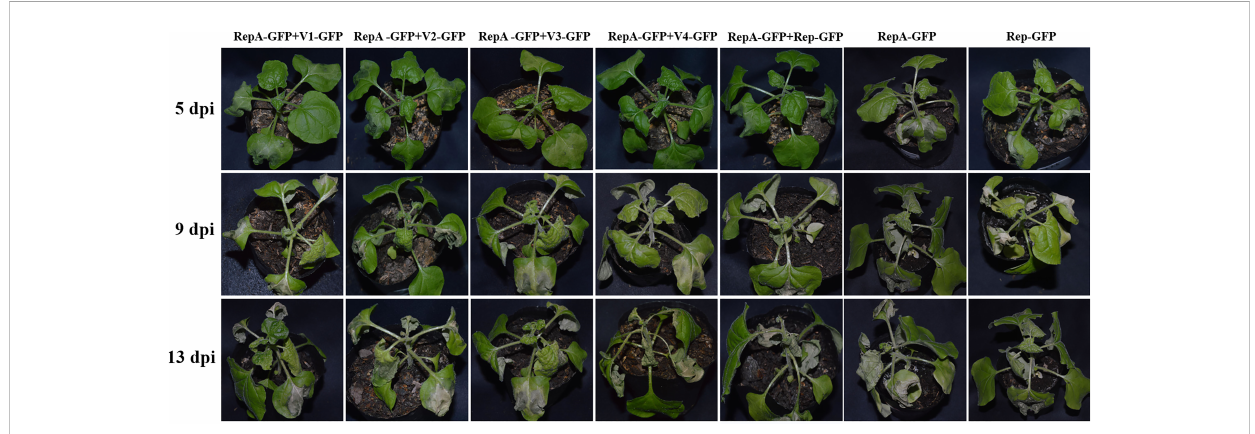
FIGURE 5 CCDaV-encoded proteins inhibited cell death induced by RepA. Each experiment was repeated three times and at least fi ve plants were used per biological replicate.